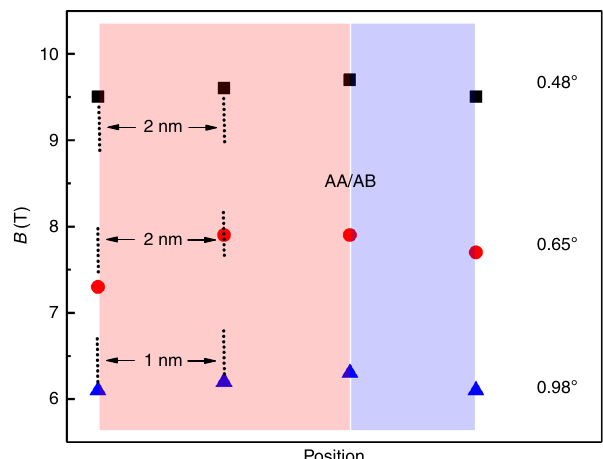
Fig. 5 The fi tted pseudo-magnetic fi eld of TBGs with different twisted angles around the region of AA/AB transtion. The obtained PMFs increase with the decreasing twisted angles and the PMF areas are distributed near the AA regions with its maximum value occuring at the AA/AB transitions, which is highly consistent with our calculated